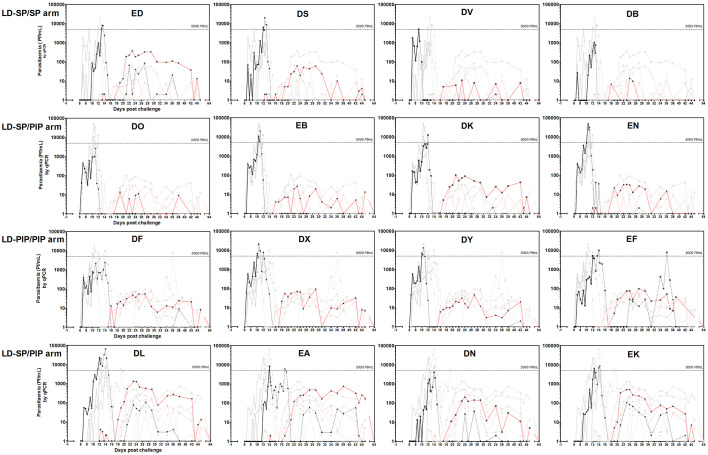
Asexual parasitemia and gametocytemia per study participant.Black line represents 18S qPCR asexual parasitemia. Black dotted-line represents 18S qPCR after treatment 1. Red line represents Pfs25 qRT-PCR gametocytemia. Grey lines represent individual PCR curves of other participants of the same group.